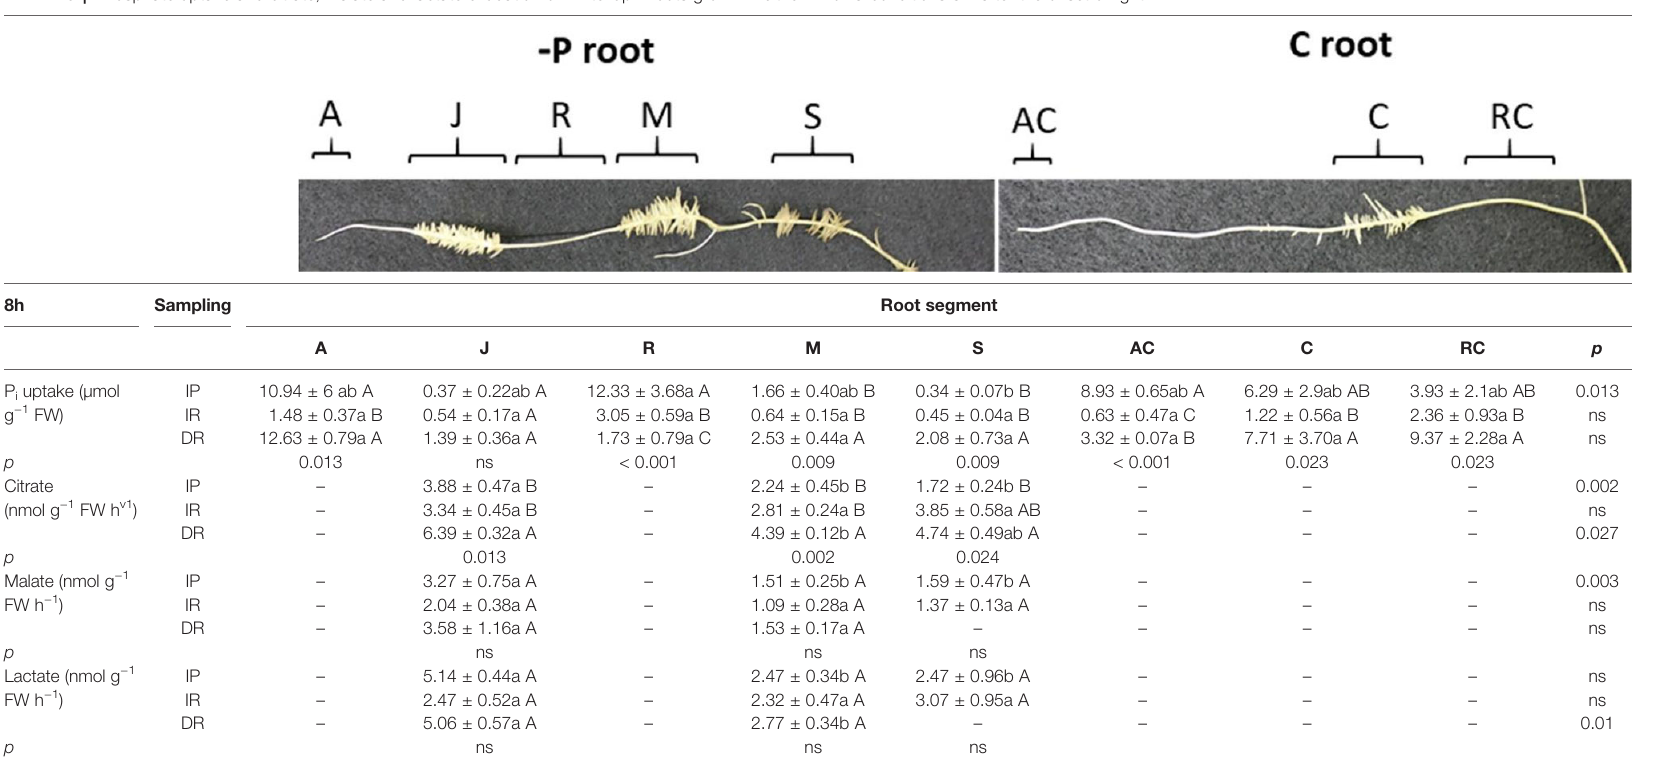
TABLE 3 | Phosphate uptake and citrate, malate and lactate exudation of white lupin roots grown in either -P or C conditions 8 h after the onset of light.